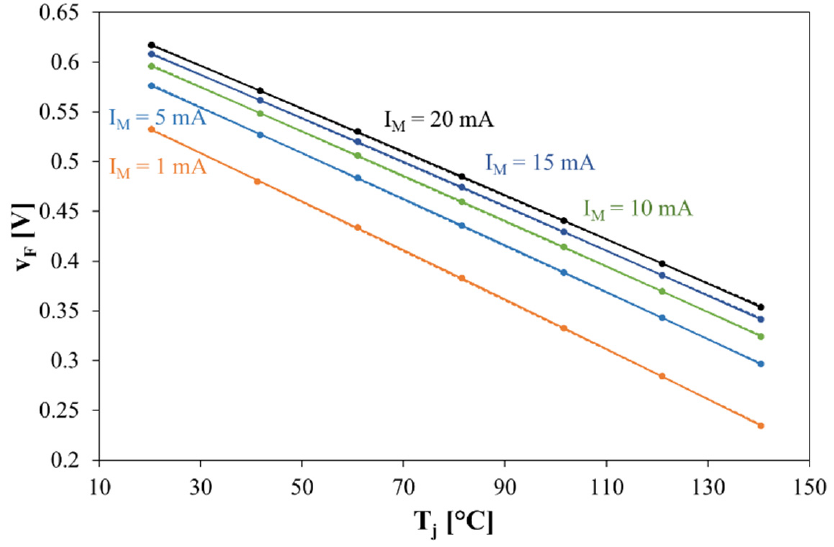
Figure 5. Thermometric characteristics of the anti-parallel diode for selected values of current I M.